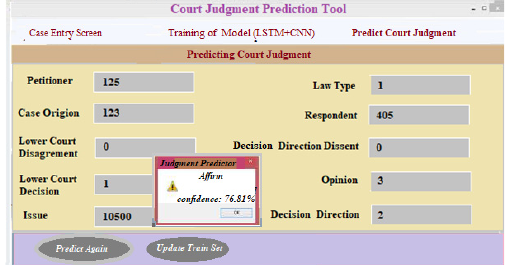
Figure 14. Interface for predicting the outcome of a court case.